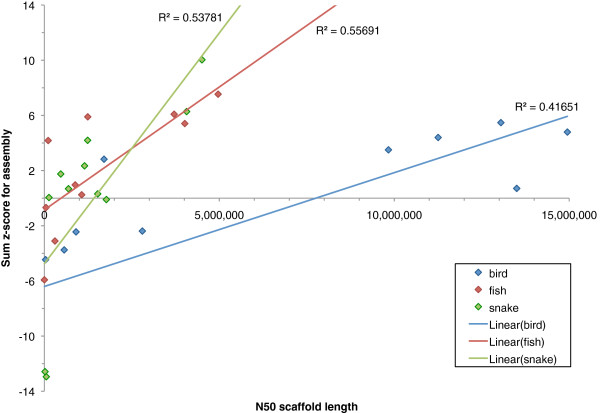
Correlation between scaffold N50 length and final z-score ranking. Lines of best fit are added for each series. P-values for correlation coefficients: bird, P = 0.016; fish, P = 0.007; snake, P = 0.005.